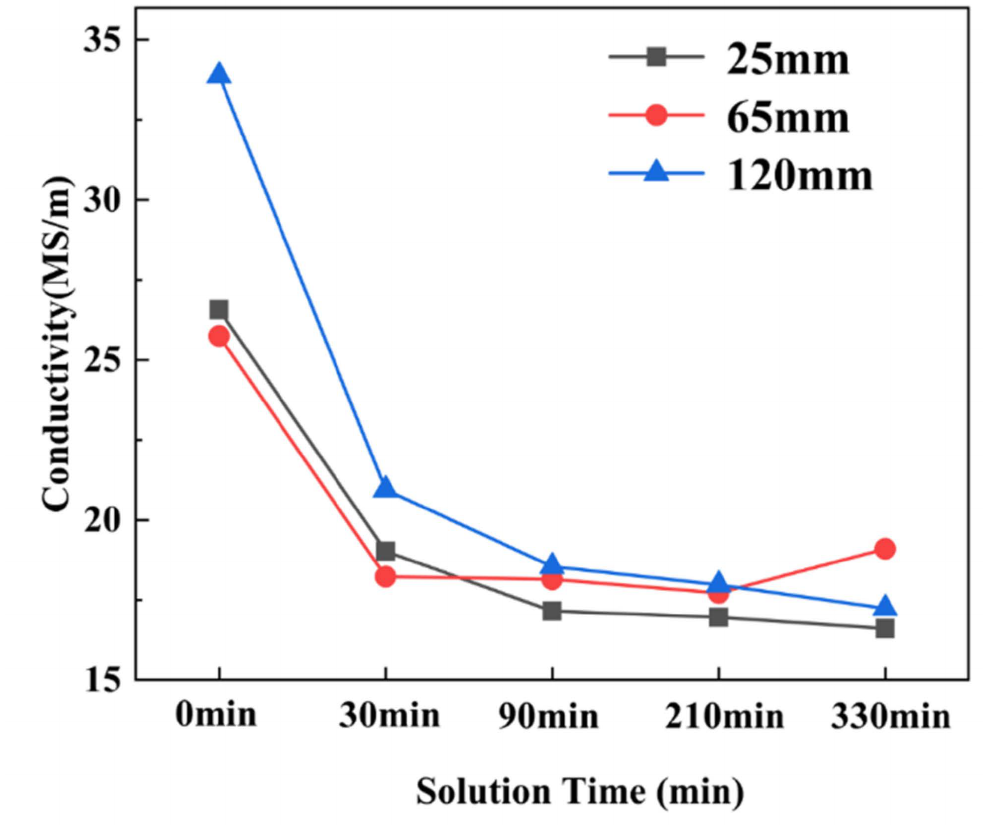
Figure 11. Conductivity results after different solution